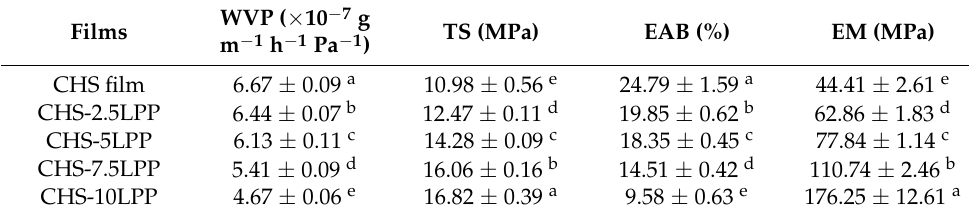
Table 3. WVP, TS, and EAB of